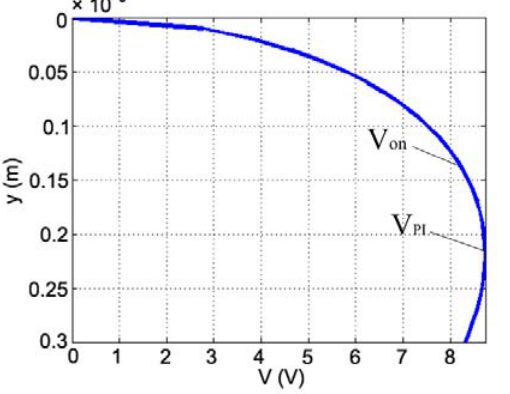
Figure 8. The simulation of the displacement and the driving